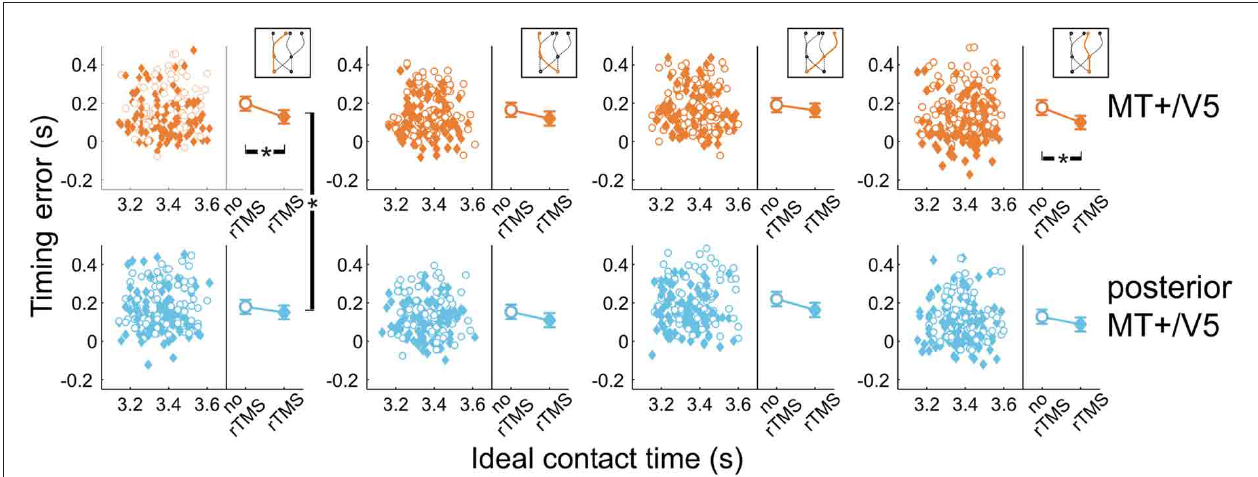
open circles); individual differences are averaged out for illustrative purposes. The right part of each panel depicts the average timing errors; error bars indicate standard errors. Asterisks indicate significant